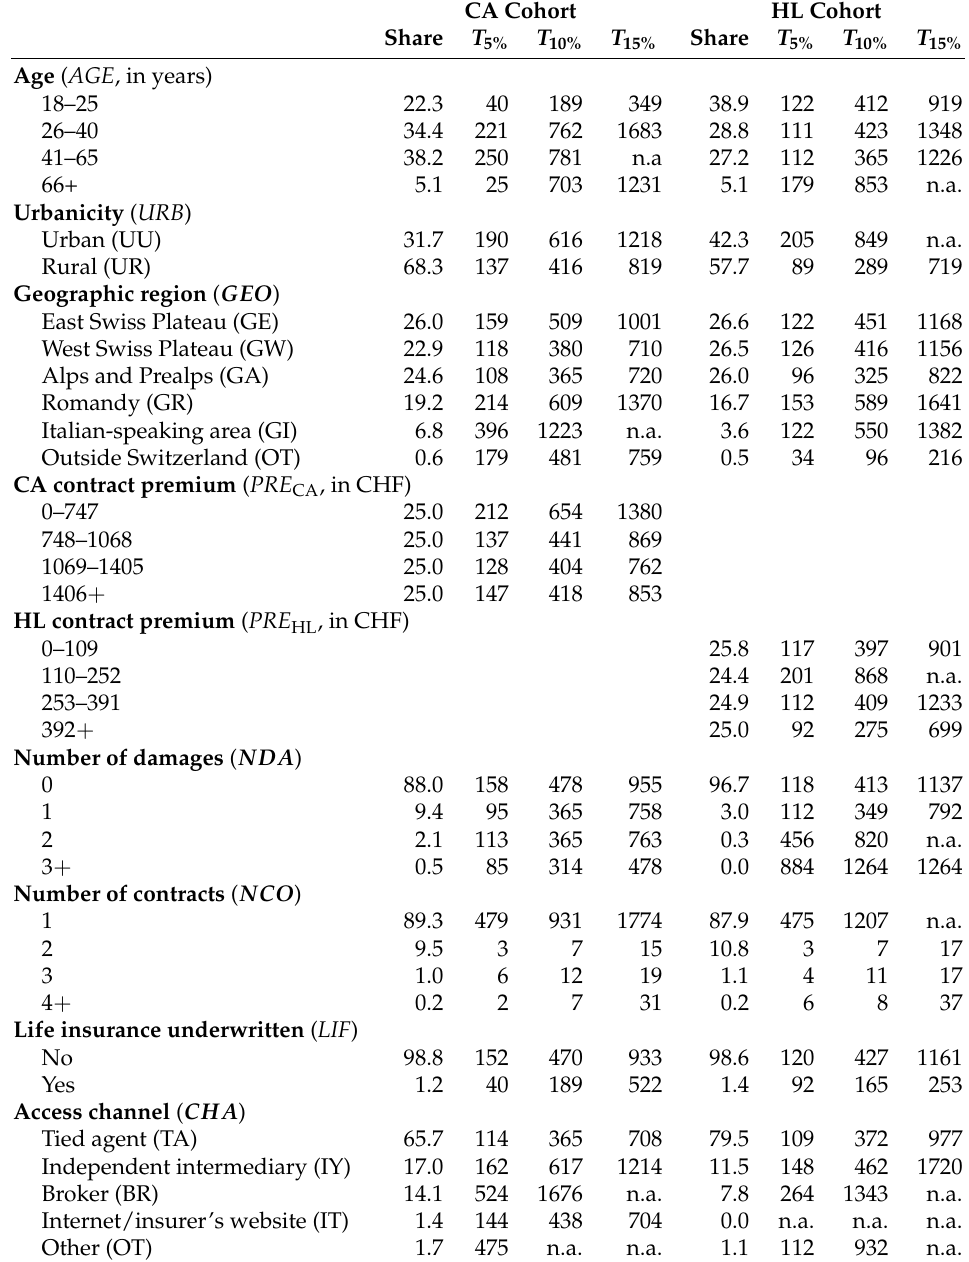
Table 2. Shares (in %) and T 5% , T 10% , T 15% inter-purchase time quantiles (in days) along